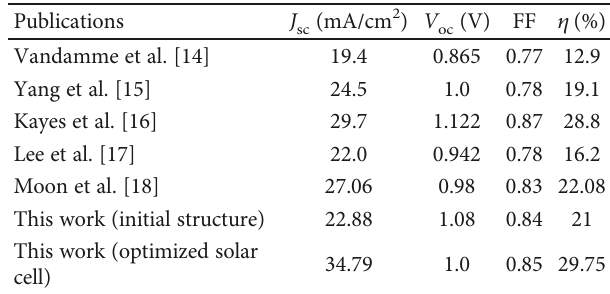
Cathode current versus anode bias Data from IVcurvlight.dat